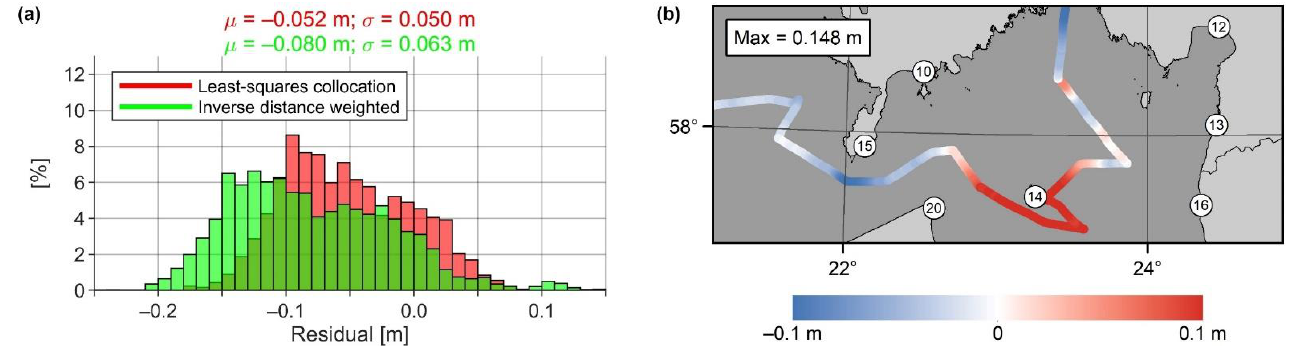
Figure 18. ( a ) Histograms of residuals (all campaigns combined): the impact of the DB prediction method, and ( b ) filtered, corrected, and least-squares adjusted residuals, derived using inverse dis- tance weighted interpolation for DB prediction. Numbered circles in ( b ) denote the used TG sta- tions.